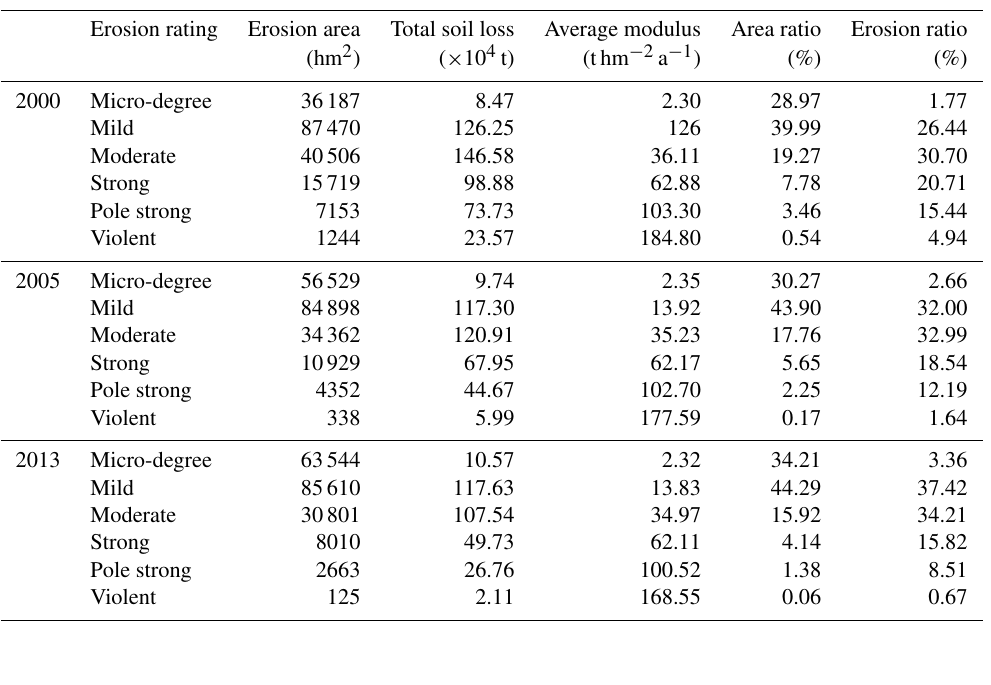
Table 3. The soil erosion estimates for different periods in Yinjiang.